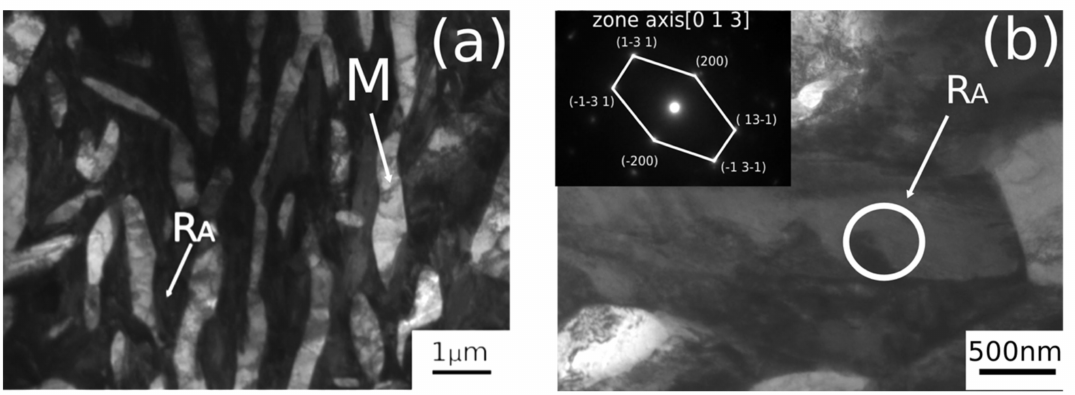
Figure 13. TEM micrographs ( a ) and ( b ) and electron di ff raction patterns.